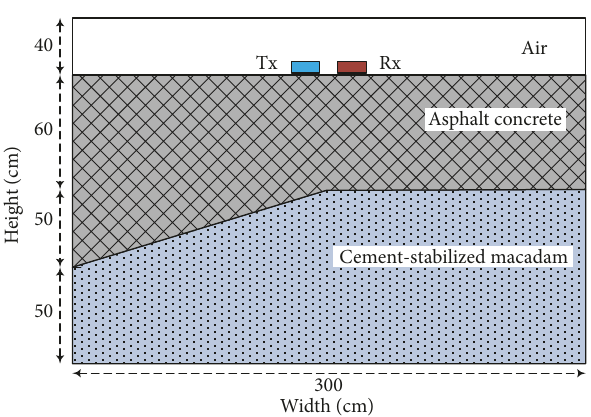
Figure 8: A sketch of the embankment ground-penetrating radar (GPR) model simulated in this study.